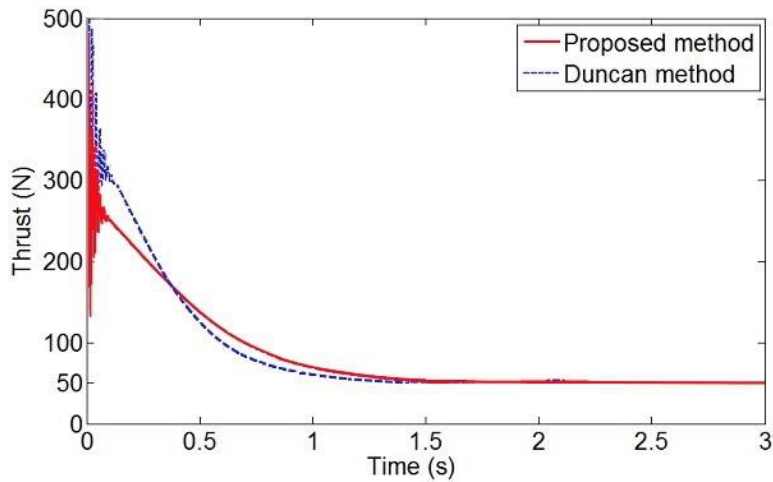
Figure 11. Thrust versus time characteristics using the proposed and Duncan’s